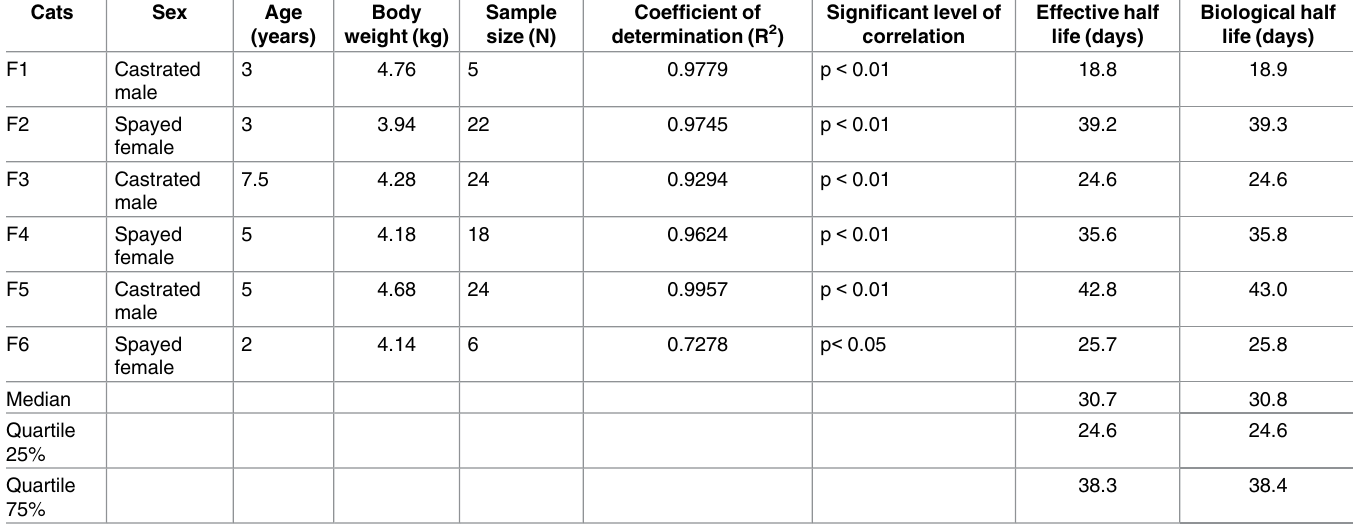
Table 2. 137 Cs biological half-lives and parameters of the decay curves of radiocesium in feline bodies. Cats Sex Age